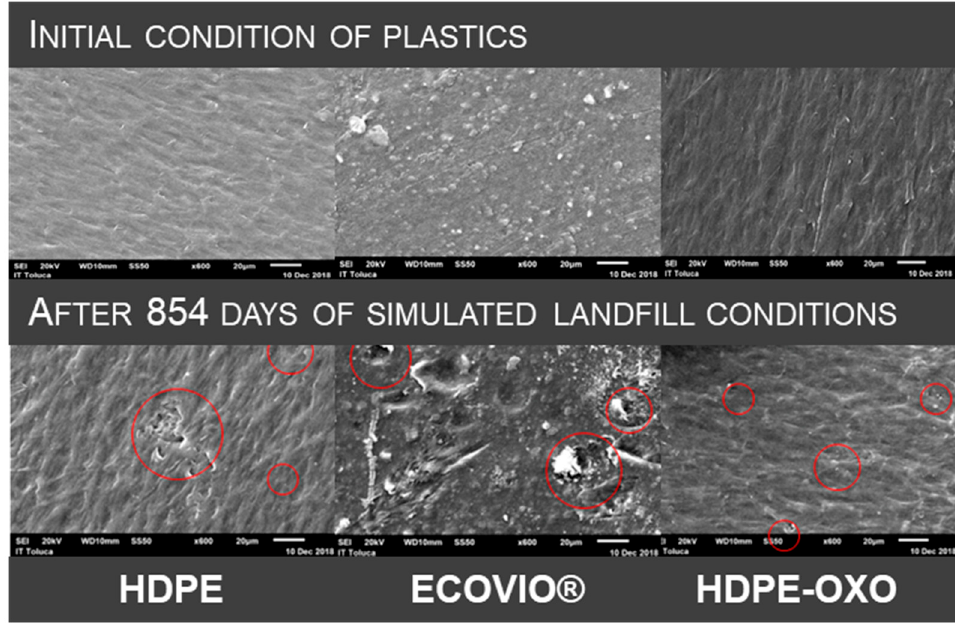
Figure 4. SEM images of high-density polyethylene, compostable plastic ECOVIO ® , and oxo-degradable polyethylene films after exposition to simulated landfill conditions.